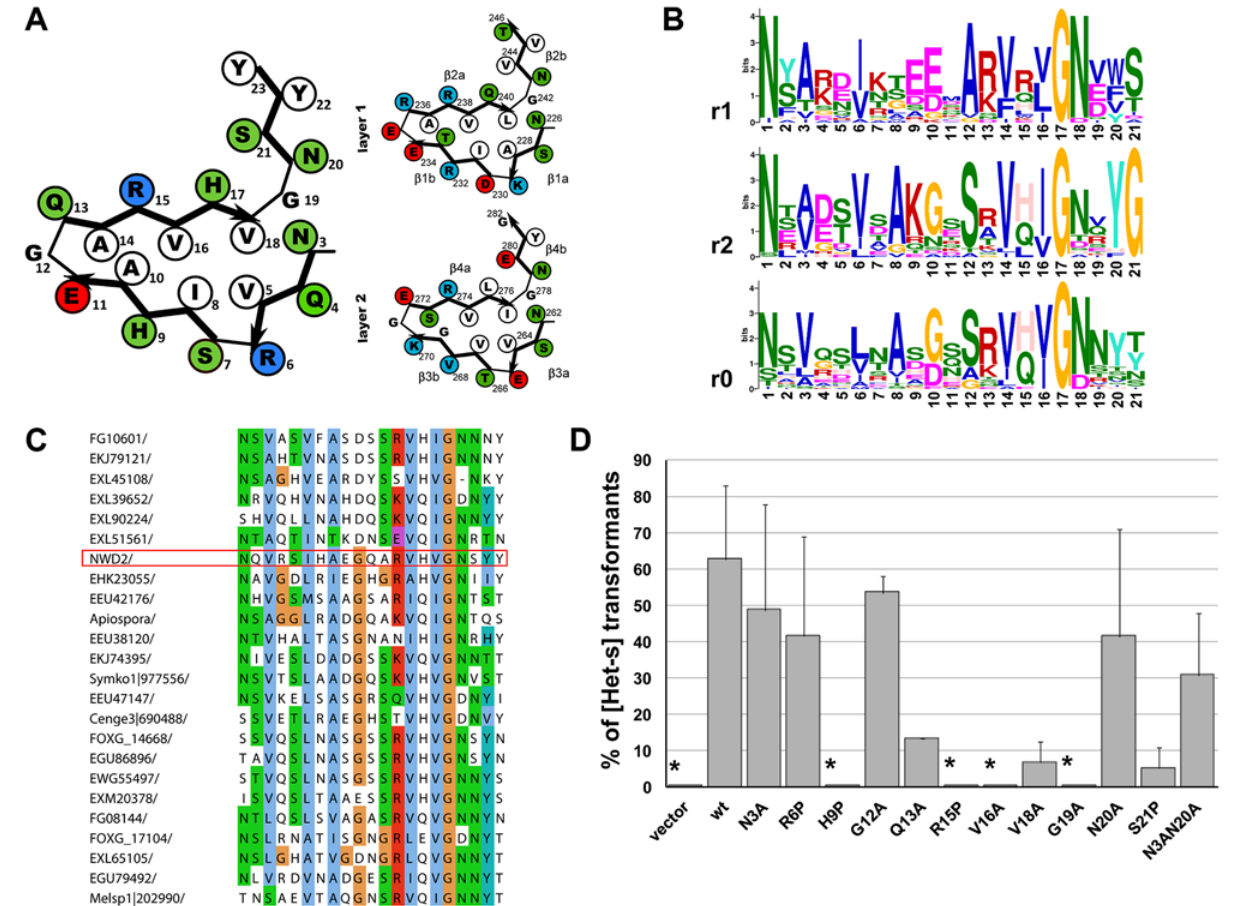
Fig 3. Mutation of conserved residues of the N-terminal region of NWD2 affect [Het-s]-inducing activity of chimeric nwd2 alleles. A. An homology model of the NWD2(3 – 23) region based on the HET-s(218 – 289) β -solenoid fold (after [24]) is given together with a graphical representation of the structure of the two repeats of the HET-s PFD (after [18,19]). B. Comparison of the sequence conservation in repeats 1 and 2 of HET-s homologs (noted r1 and r2) and NWD2 homologs found in various pezizomycotina (noted r0). The consensus sequences were generated using MEME; the size of the letter reflects conservation; scale is given in informational content measured in bits. C. Alignment of the HET-s-like motif from NWD2 homologs found in various pezizomycotina. The NWD2 sequence is boxed in red. D. [Het-s]-inducing activity of wild-type and mutated nwd2 e1 alleles in a Δ PaHsp104 het-c2 background. Experiments have been carried out at least in triplicate and error bars are standard deviations; the asterisks denote that prion conversion rate was